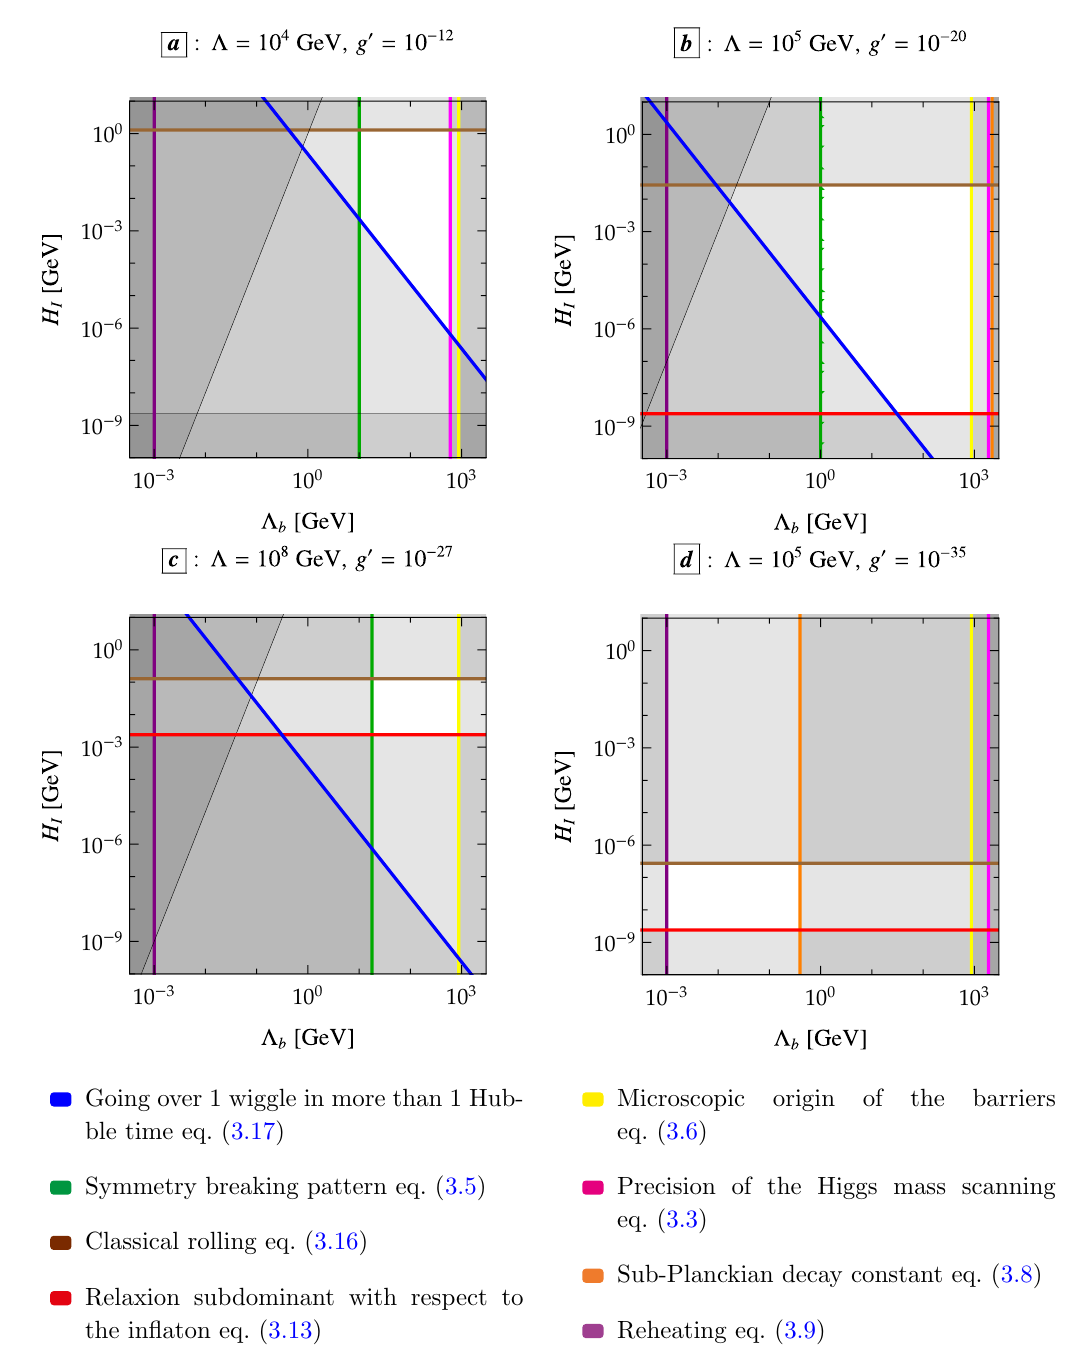
Figure 14 . Details of the origin of the constraints delimitating the green regions presented in section 3.1 and (cid:12)gure 4, for each benchmark point a , b , c , d , corresponding to the case where relaxation happens through Higgs-dependent barriers, during a stage of in(cid:13)ation, where the relaxion is a subdominant component of the energy density of the universe and where the relaxion stops because of Hubble friction (so-called GKR case) .